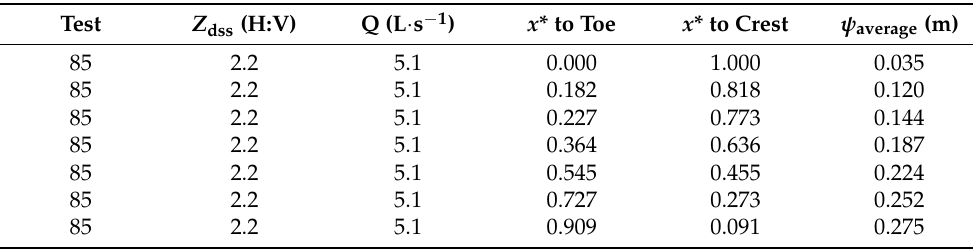
Table A2. Summary of the average hydraulic pressures ψ at the base of the physical models n o 85, 87, 90, 94, and 95 for a discharge step in the early stages of each